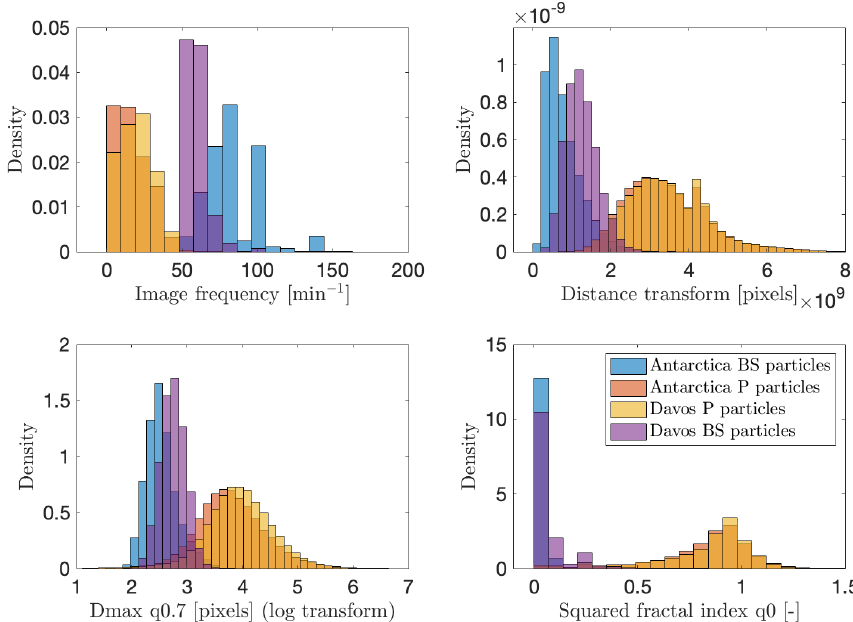
Figure 14. Histograms of selected descriptors for the training blowing snow and precipitation images from the entire Dumont d’Urville and Davos data sets.